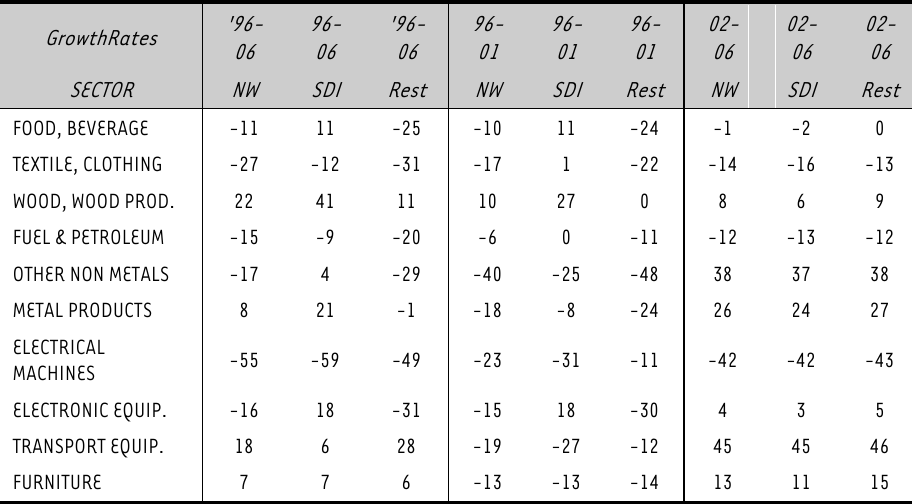
Comparison of growth